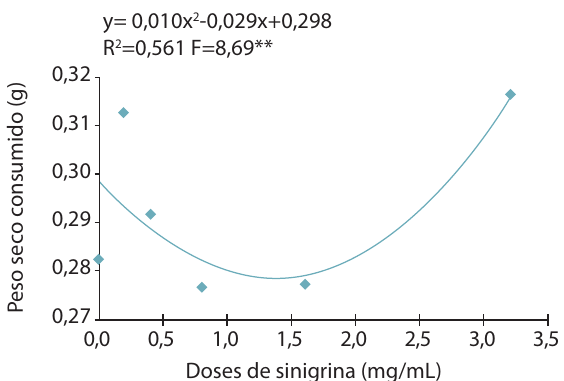
Figura 4. Curva ajustada para regressão polinomial entre o peso fresco consumido de folhas de brócolis por lagartas de Plutella xylostella e doses de